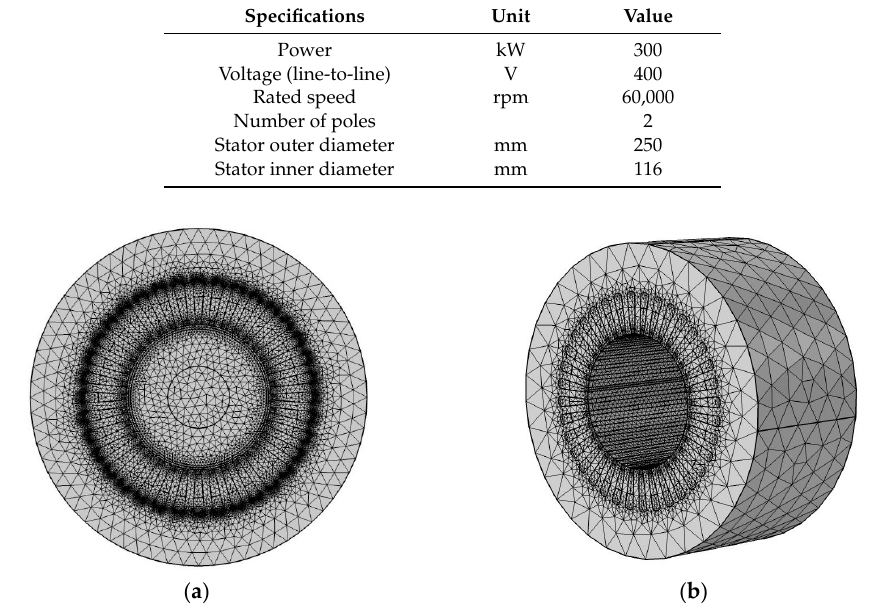
Figure 3. The finite element mesh of the motor: ( a ) the 2D triangular mesh of the rotor and stator and ( b ) the 3D tetrahedral mesh of the stator.